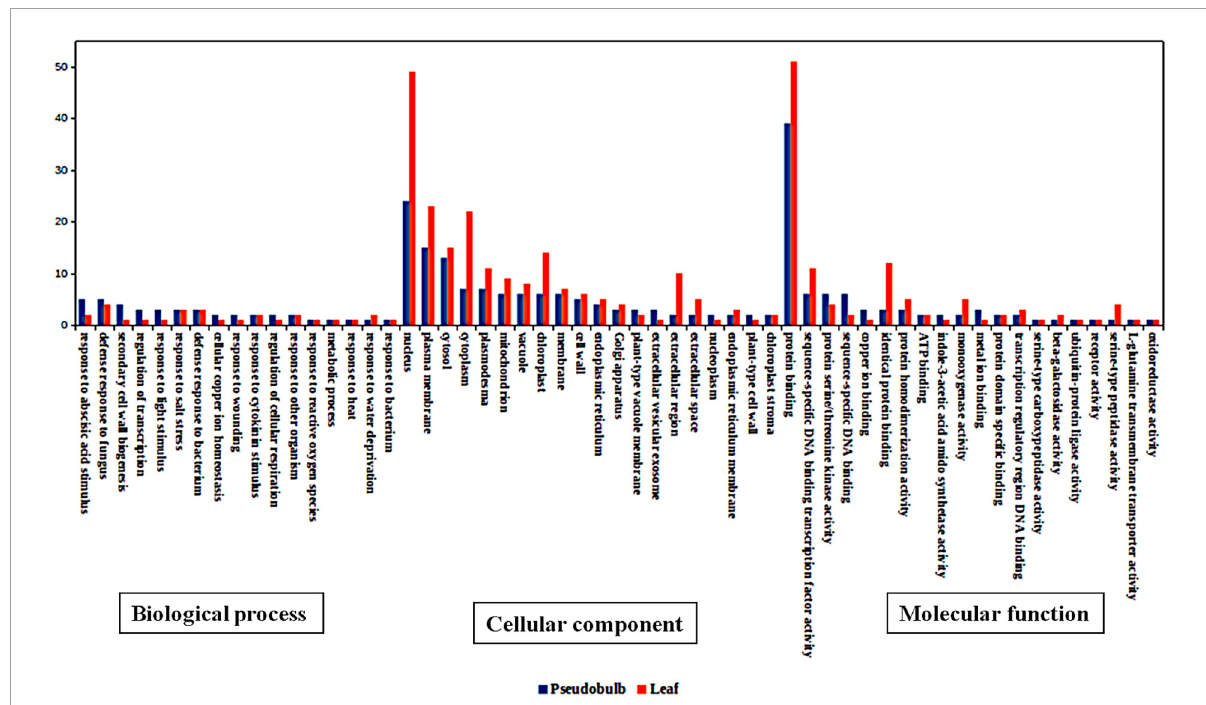
FIGURE5 Top 20 gene ontology (GO) categories of differentially expressed genes in M. acuminata for biological process, cellular component, and molecular function.